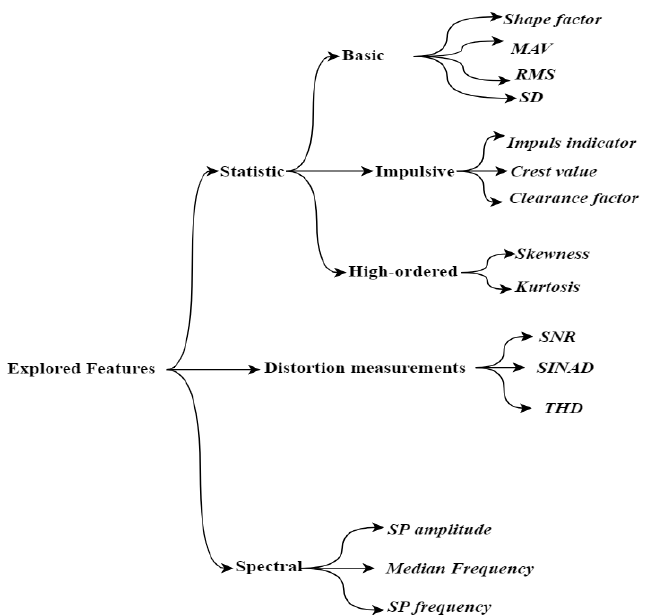
Figure 4. Representation of features. Totally 15 features (shown in italic) were extracted. These features fall into three main categories of statistic, distortion and spectral features.